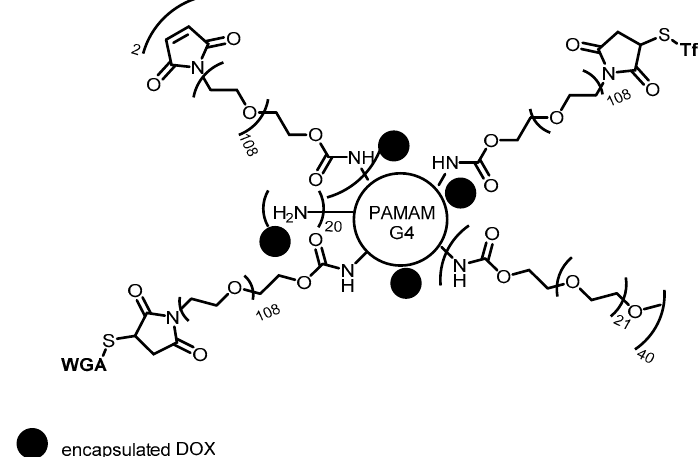
Figure 3. PEGylated dendrimers containing Tf and WGA (targeting groups) and encapsulated DOX for drug delivery to brain tumor [84].